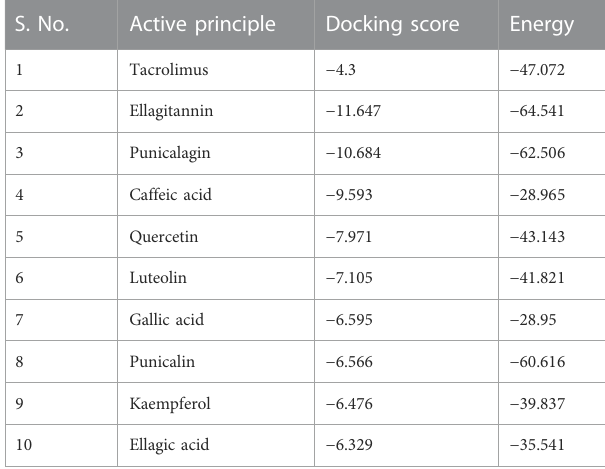
TABLE 3 Molecular docking score and the generated energy with respective ligands. S.